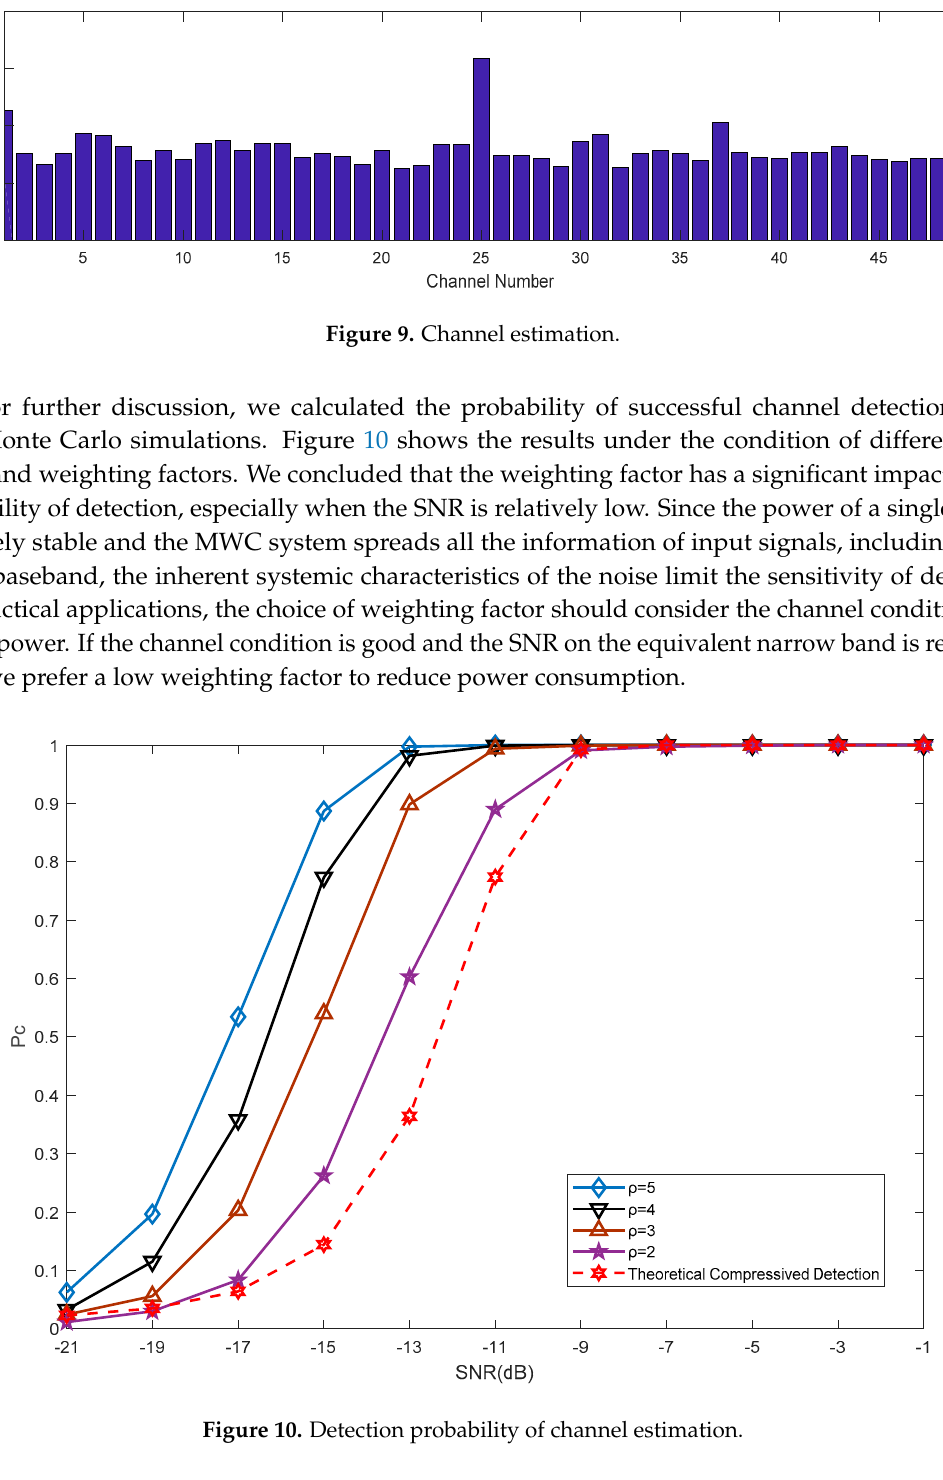
Figure 8. Single hop spectrum.